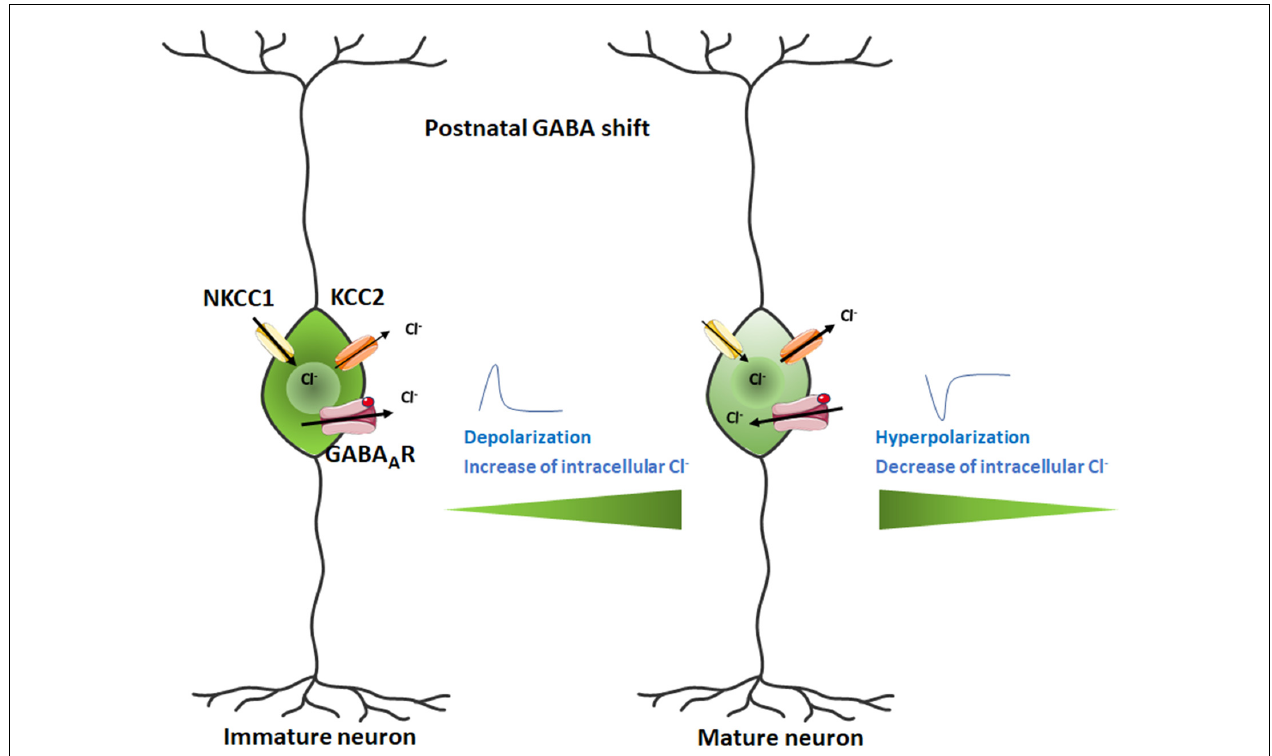
FIGURE 4 | Switch in GABA action from excitatory in the developing mammalian brain to inhibitory in the postnatal brain. The Cl - ion flux is reversed during the neurodevelopmental change, transforming the depolarizing current into a hyperpolarizing signal. Figure created using Servier Medical Art Commons Attribution 3.0 Unported License (http://smart.servier.com). Servier Medical Art by Servier is licensed under a Creative Commons Attribution 3.0 Unported